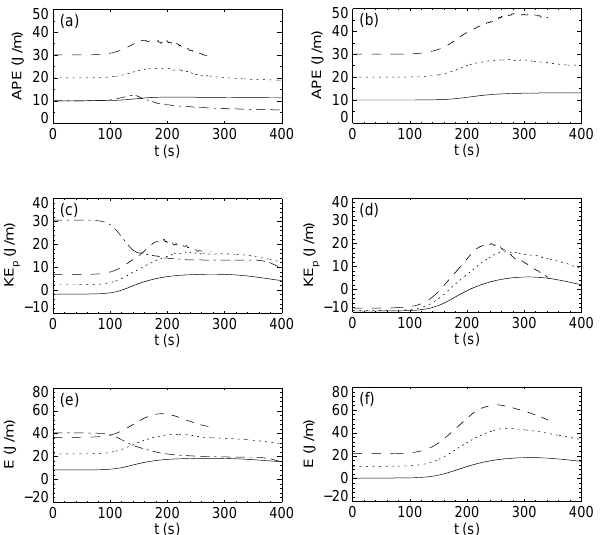
Fig. 10. Evolution of the perturbation energy for simulations of in- ternal solitary waves passing through a turning point. (a, b) Avail- able potential energy ¯ E a . (c, d) Perturbation kinetic energy ¯ E kp . (e, f) Total perturbation energy ¯ E a + ¯ E kp . (a, c, e) and (b, d, f) are for U m = − 0 . 1 and − 0 . 2ms − 1 , respectively. Curves are for dif- ferent initial wave amplitudes: ¯ E a ( 0 ) = 10 (solid), 20 (dots) and 30 (dashed) Jm − 1 . Dash-dot curve in panels (a, c, e) are for wave with − 1 and U − 1 . ¯ E m = 0 . 1ms a ( 0 ) = 10Jm